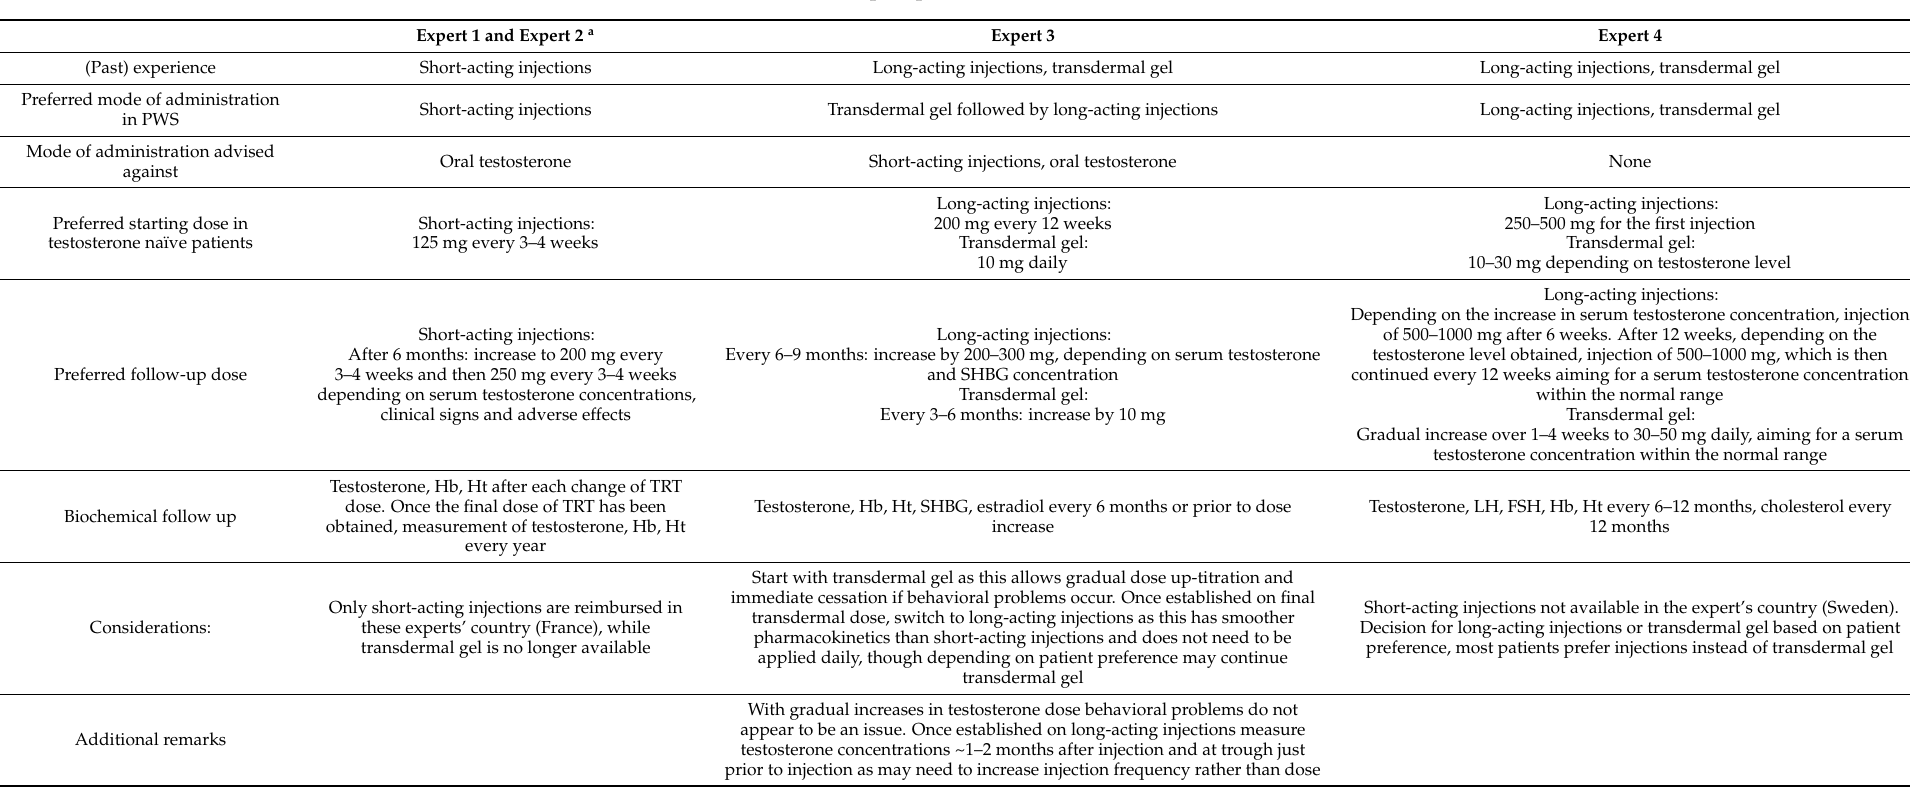
Table 7. Expert panel discussion (Part